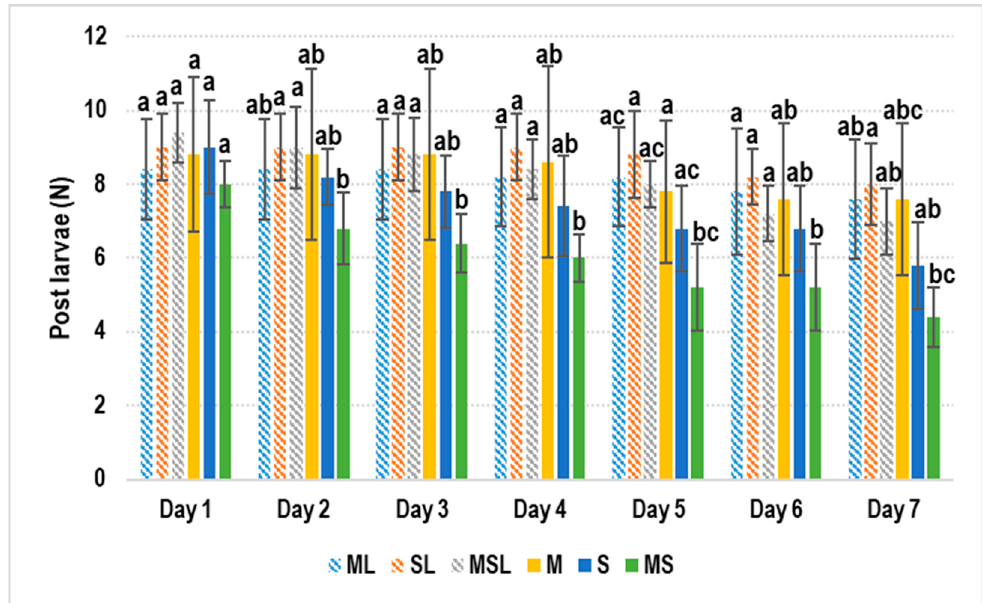
Figure 2. Panulirus homarus prey experiment. The results showed a significant difference on Day 2. There were no significant differences between the three groups using live shrimp but there were significant differences from the non-live shrimp group. ML: Fresh clams and live shrimp; SL: Fresh shrimp and live shrimp; MSL: Fresh clams, fresh shrimp, and live shrimp; M: Fresh clams; S: